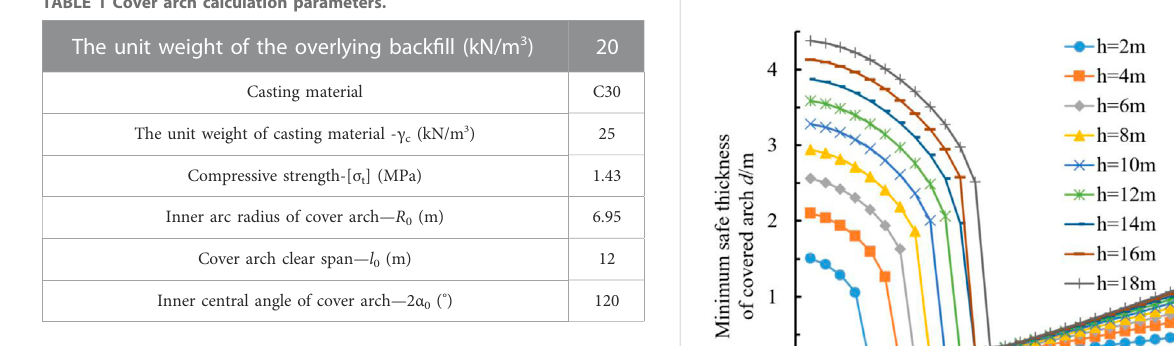
TABLE 1 Cover arch calculation parameters.